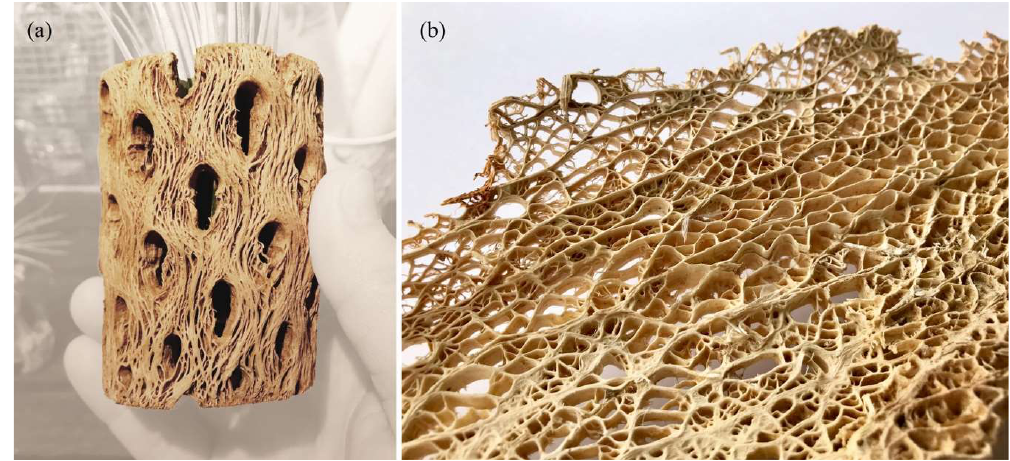
Figure 20. Students study the dried cactus skeletons of the Buckhorn Cholla ( a ) and Prickly Pear ( b ).